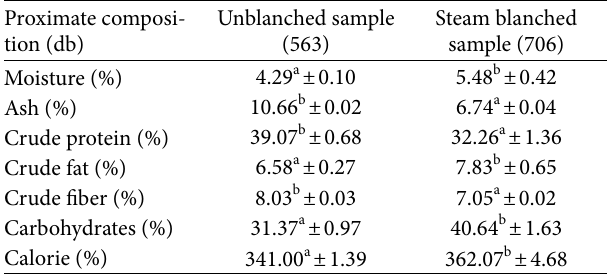
; mean ± SD. db = dry basis. Values in a row followed by different letters 푛 = 3 in superscript are significantly different